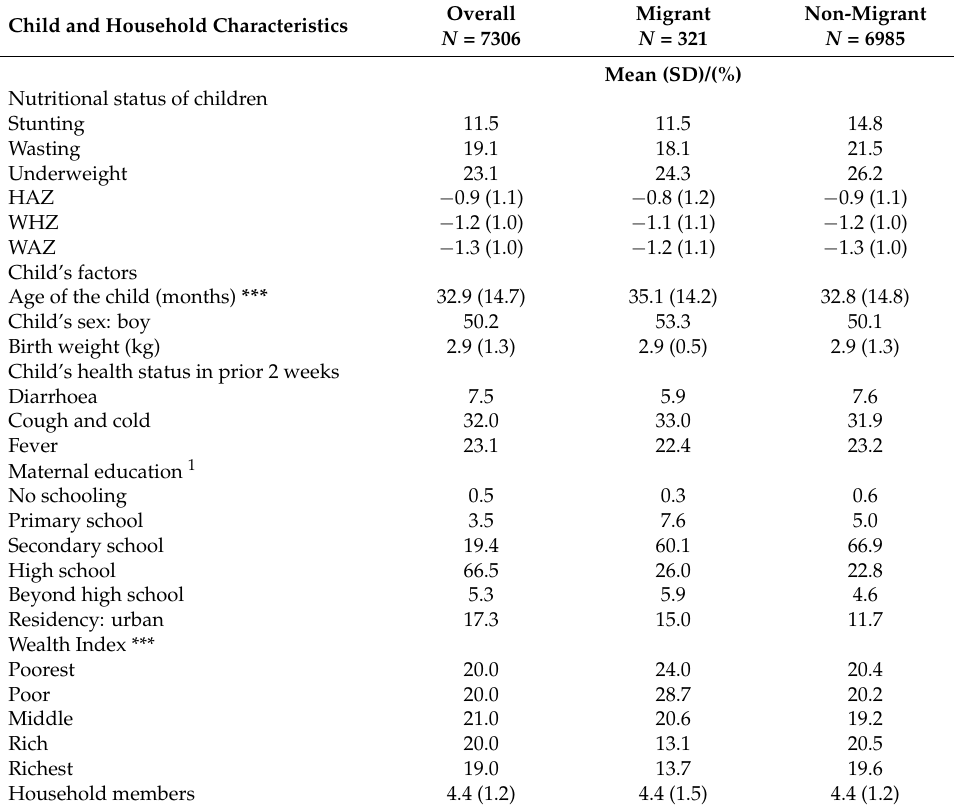
Table 1. Child and household characteristics for migrant and non-migrant households 1